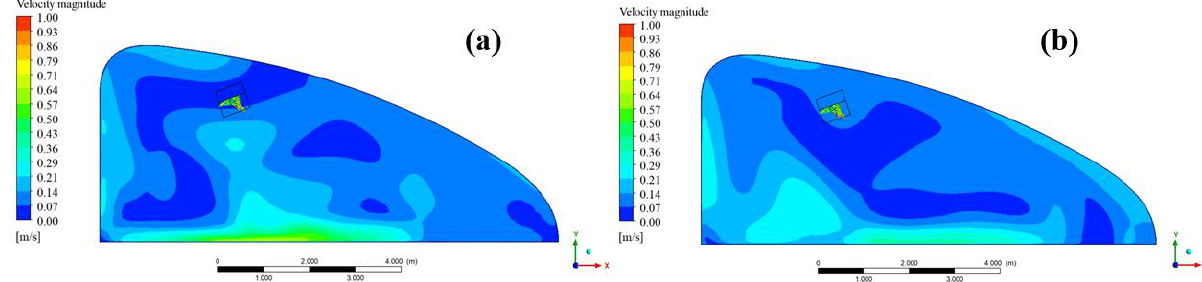
Figure 11. Velocity distribution contours for vertical profiles when the fan tilt angle was − 70 ◦ : plane A ( a ) and plane C ( b